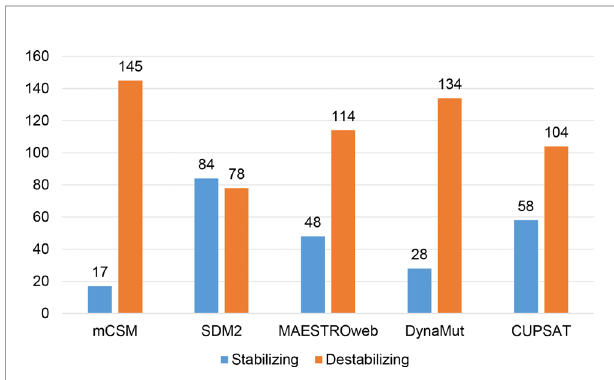
FIGURE 1 | Distribution of stabilizing and destabilizing mutations in SARS- CoV-2 Spike protein predicted by structure-based tools.